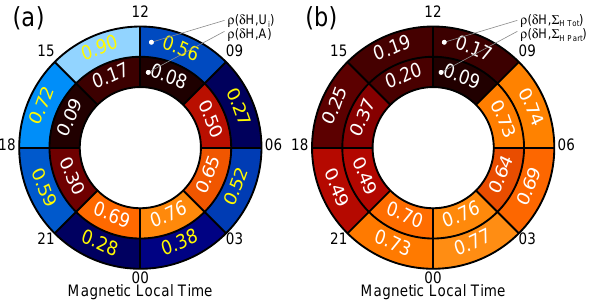
Fig. 6. Clock diagrams showing the correlation of magnetic pertur- bation (a) with ion velocity (absorption) in blue (red) and (b) with the total (particle component) Hall conductance in outer (inner) cir- cular band for different MLT. The colour coding is representative of the correlation from low (dark) to high (light).